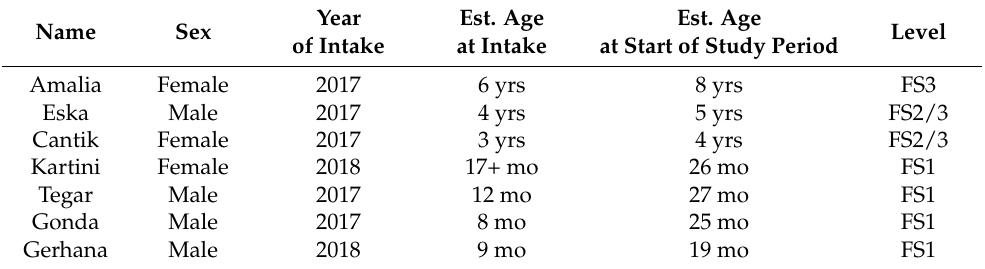
Table 1. Biographic information on subjects in the forest school.